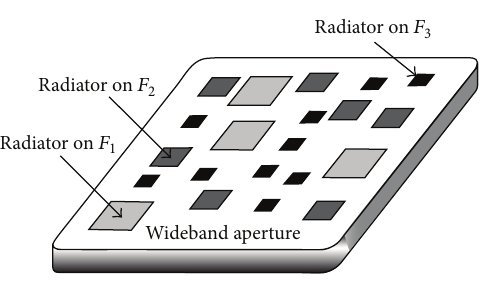
Figure 24: Shared aperture antenna [61].